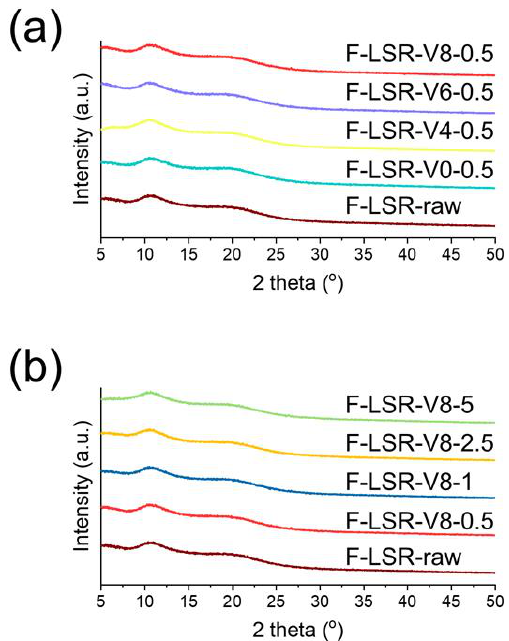
Figure 3. XRD patterns of the POSS-Vs with ( a ) various types of POSSs and ( b ) different amounts of POSS-V8.